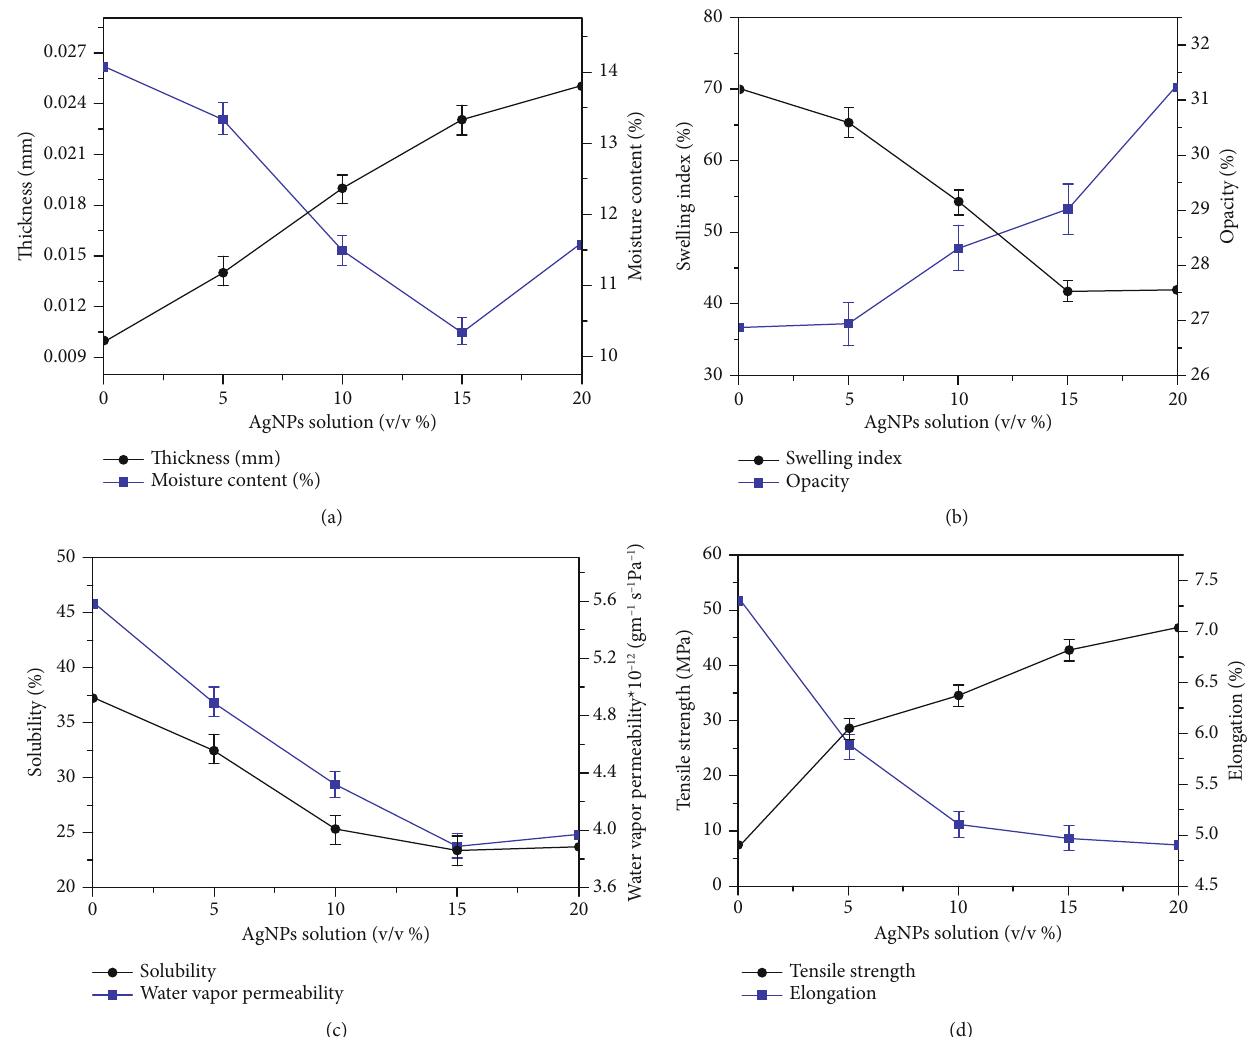
Figure 2: Impact of AgNP solution. (a) Thickness & MC , (b) SI & OP , (c) WS & WVP , and (d) MS and E